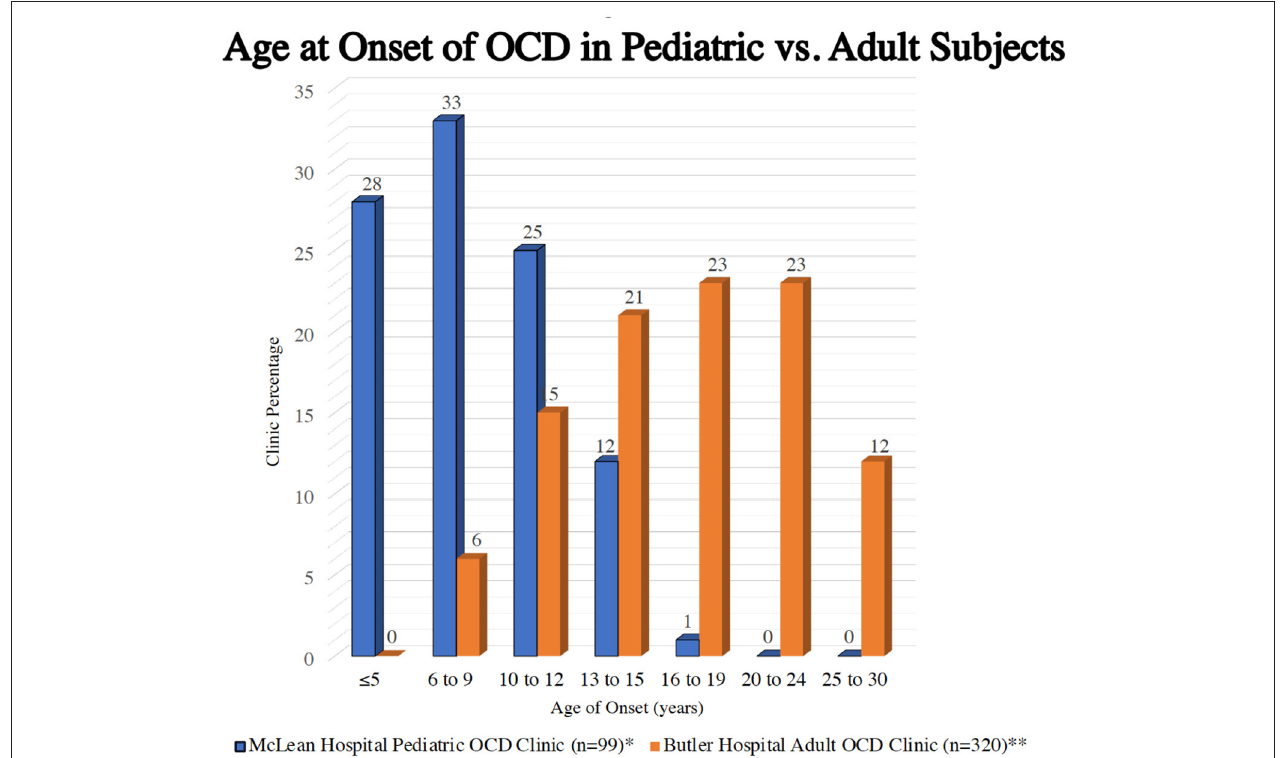
FIGURE 1 | A Bimodal distribution of incidence of OCD across the lifespan. * Geller et al. (22). ** Rasmuseen et al.